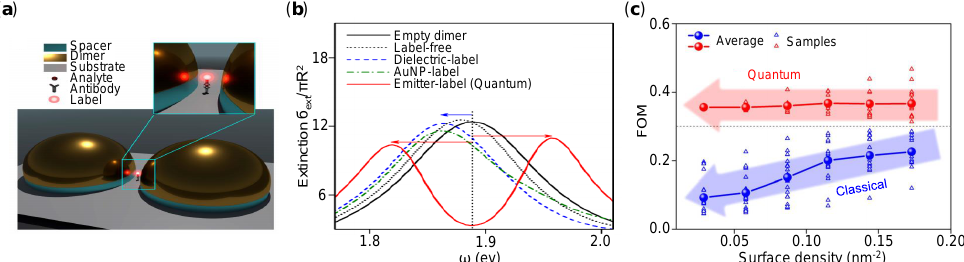
Figure 13. Quantum plasmonic sensors by strong coupling. ( a ) Schematic of the strong-coupling immunoassay setup. ( b ) Comparisons of performance for different plasmonic sensors. ( c ) FOM as a function of the surface density of analyte-emitter complexes. Reprinted ( a – c ) with permission from Reference